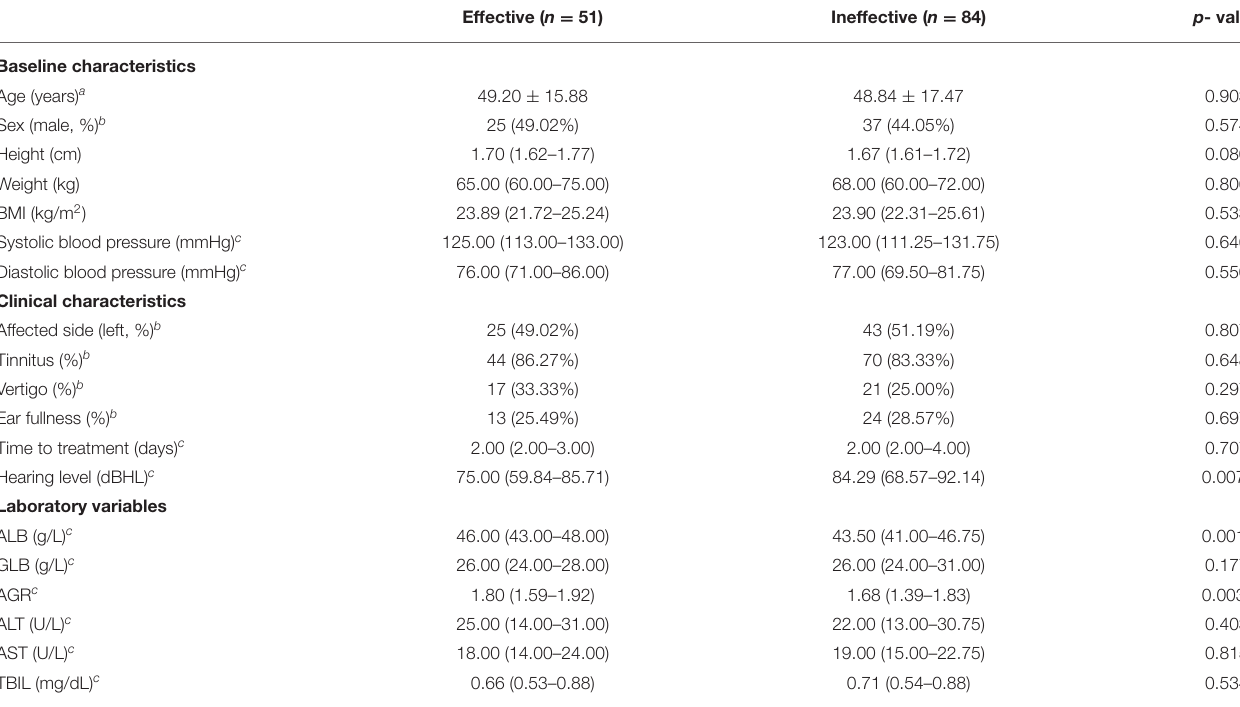
TABLE 3 | Demographics and laboratory variables in the SSNHL with different